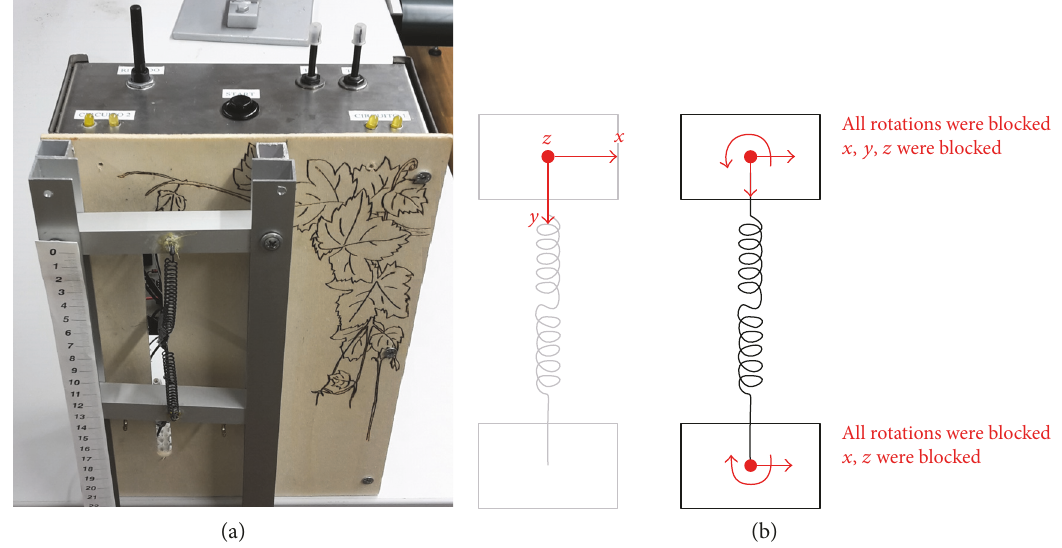
Figure 8: (a) Testing system: two SMA springs connected by a perversion element at one extremity and constrained on the other as highlighted in the (b) schematic representation of free and constrained DoFs.